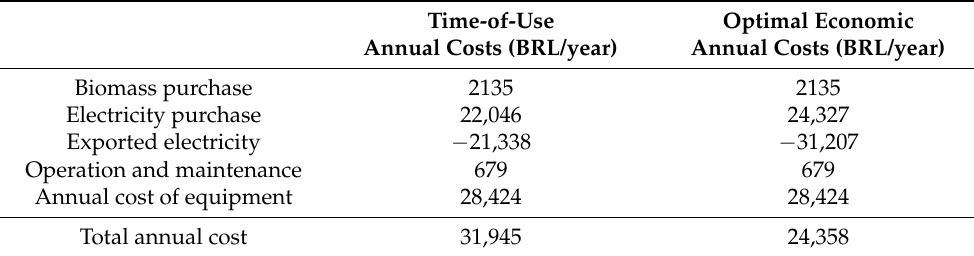
Table 5. Annual costs: time of use vs. optimal economic